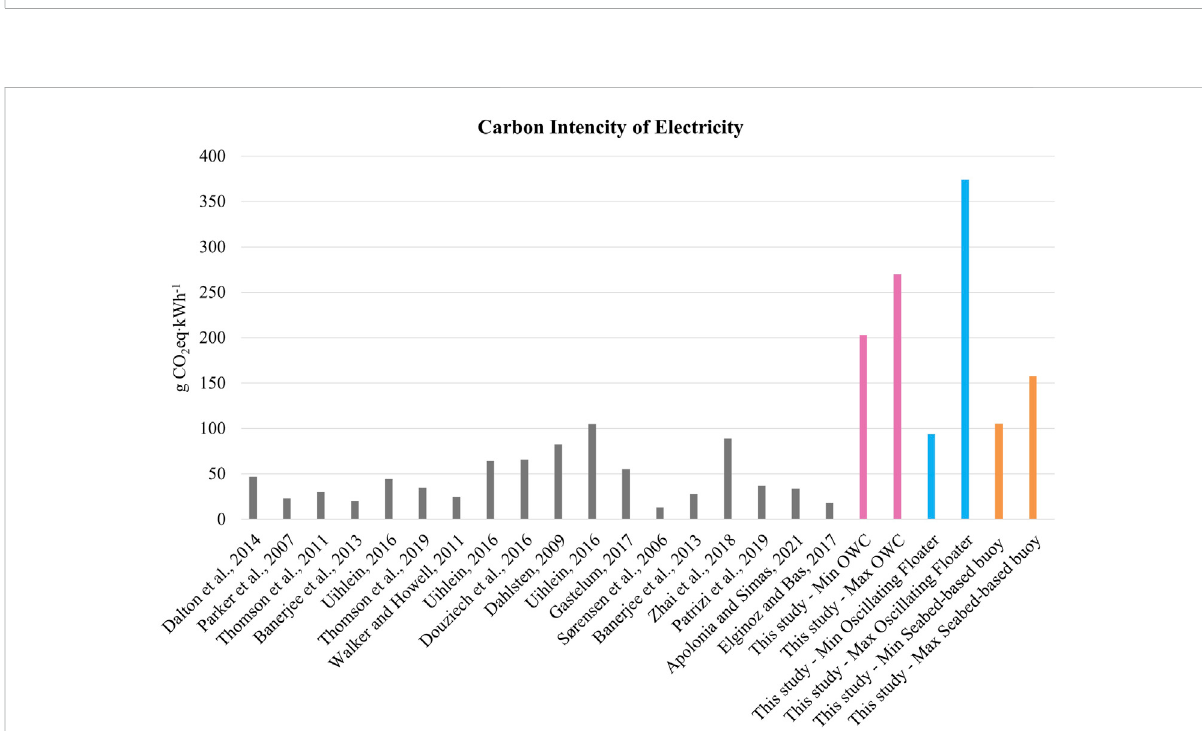
Frontiers in Energy